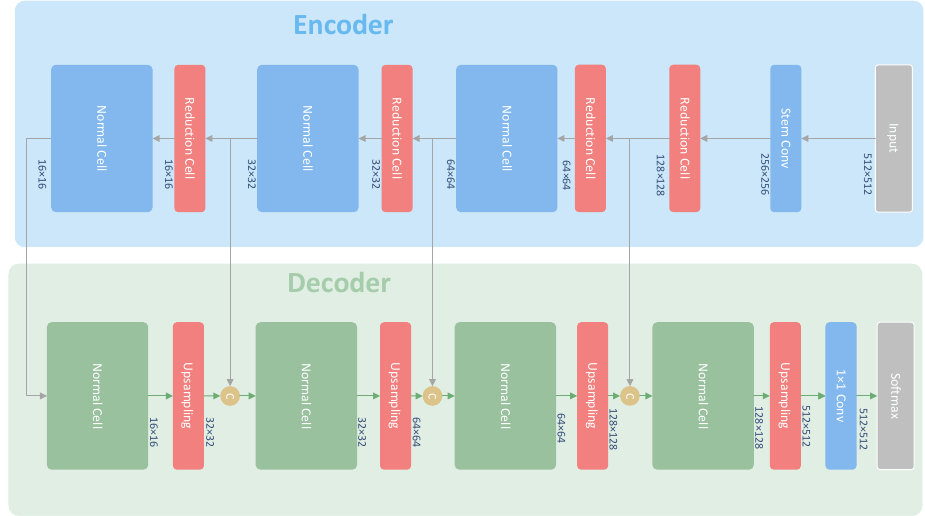
Figure 4. The architecture of U-NASNetMobile. Normal Cells and Reduction Cells are the structures obtained via neural architecture searching [39]. The yellow circles are concatenation layers.